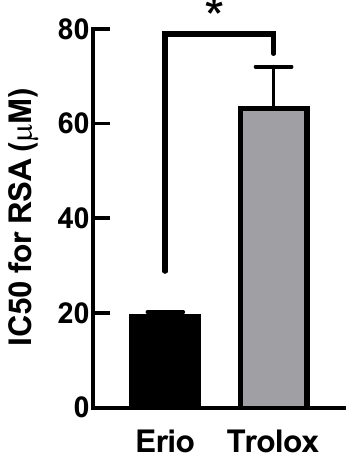
Figure 5. Eriodictyol has potent radical scavenging activity (RSA). The RSA of compounds was evaluated using the DPPH assay. The IC 50 of eriodictyol required to decrease the radical activity of DPPH was calculated. The IC 50 for the RSA of eriodictyol was 3.2-fold greater than that of Trolox (eriodictyol, 19.9 ± 0.3 µ M versus Trolox, 63.8 ± 8.3 µ M; n = 3; mean ± SEM, * p <